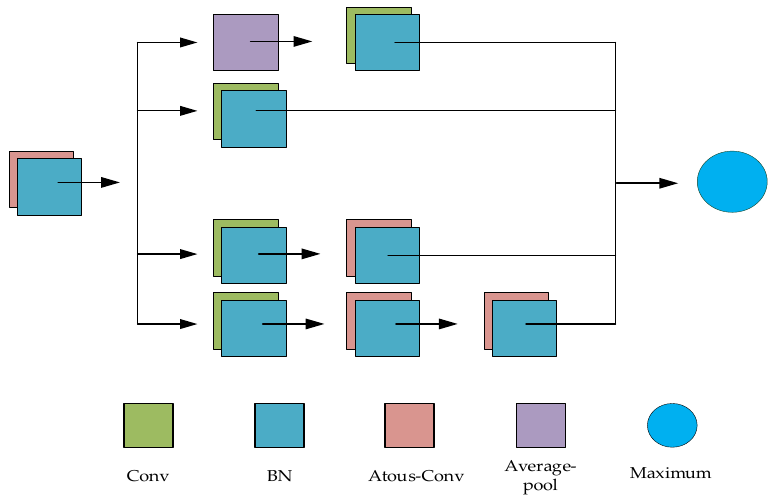
Figure 3. Structure of the Atrous-Inception module.